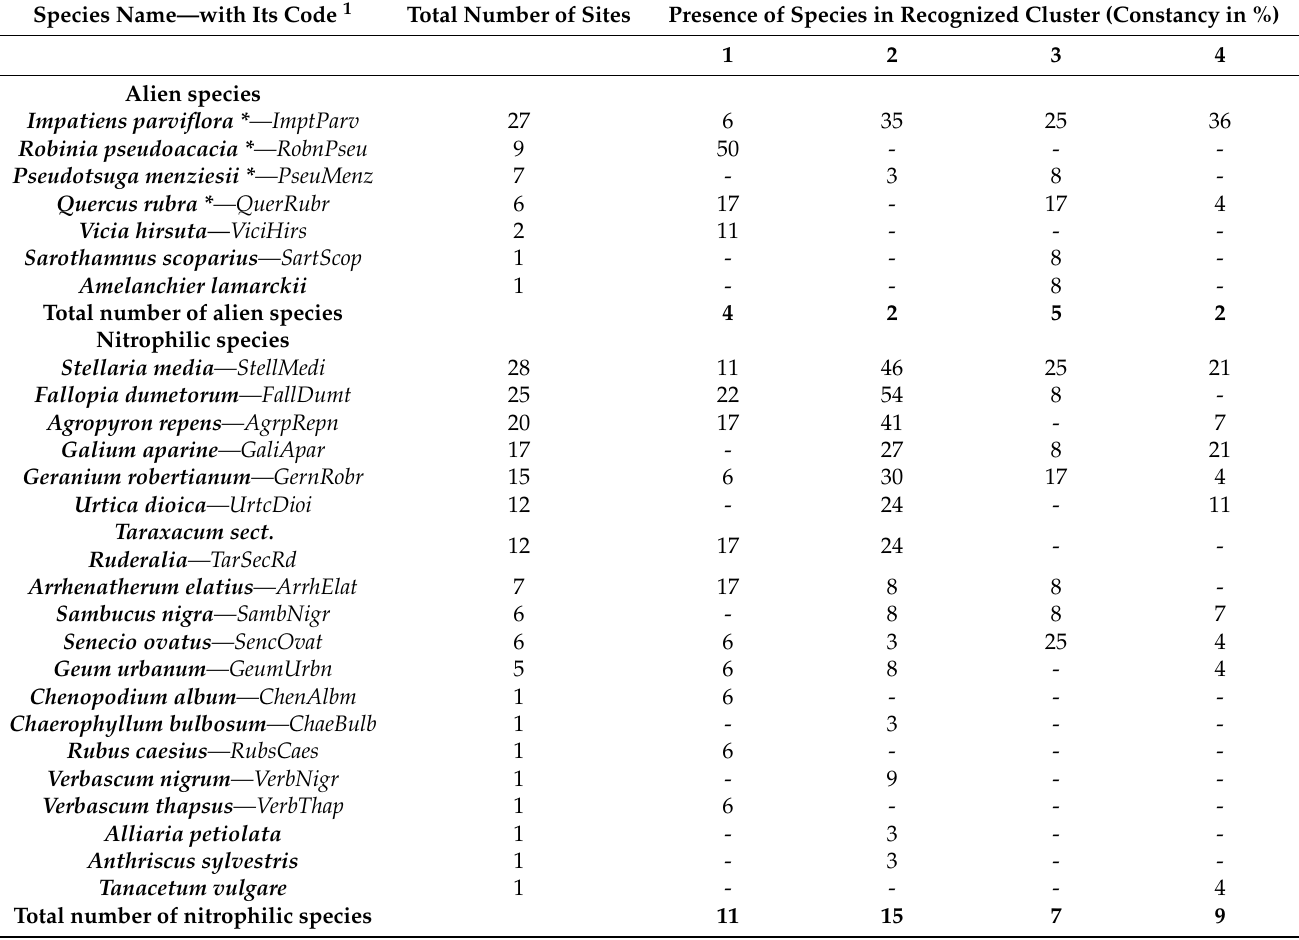
Table 3. The list of alien (including invasive) and nitrophilic species (EIVs for nutrients ≥ 7) recorded in forest communities on serpentinites in SW Poland (Sudetes Foreland). For each species, the total number of sites and the percentage share in a given cluster are